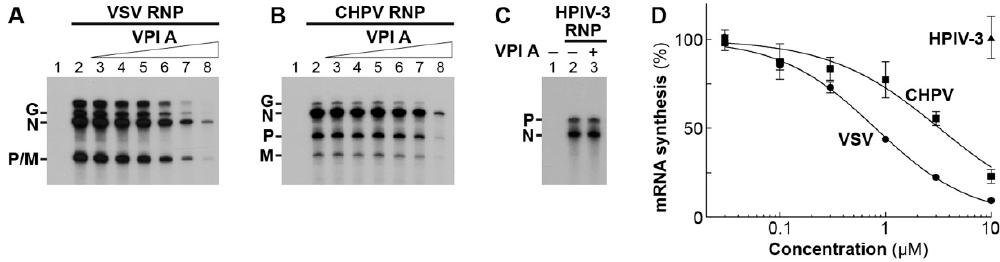
Figure 6. VPIs A and B inhibit mRNA synthesis of VSV and CHPV in vitro. In vitro mRNA synthesis was carried out with VSV ( A ), CHPV ( B ), or HPIV-3 ( C ) RNP in the presence or absence of VPI A (A and B, lanes 3–8, 0.03, 0.1, 0.3, 1, 3, 10 µM; C, lane 3, 10 µM). Deadenylated mRNAs were analyzed by